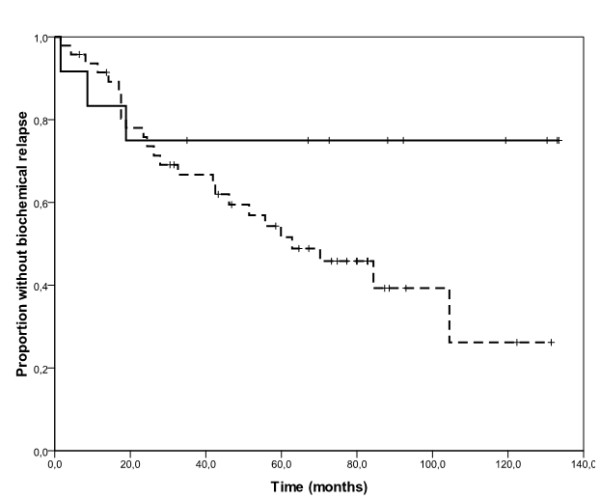
Kaplan-Meier estimates of time to biochemical relapse according to Gleason Score category. The solid line represents patients with low score tumours and the dashed line represents those with high score tumours. Median time to biochemical relapse was not reached for patients with low score tumours and was 63 months for those with high score tumours (log-rank test, p=0.08).